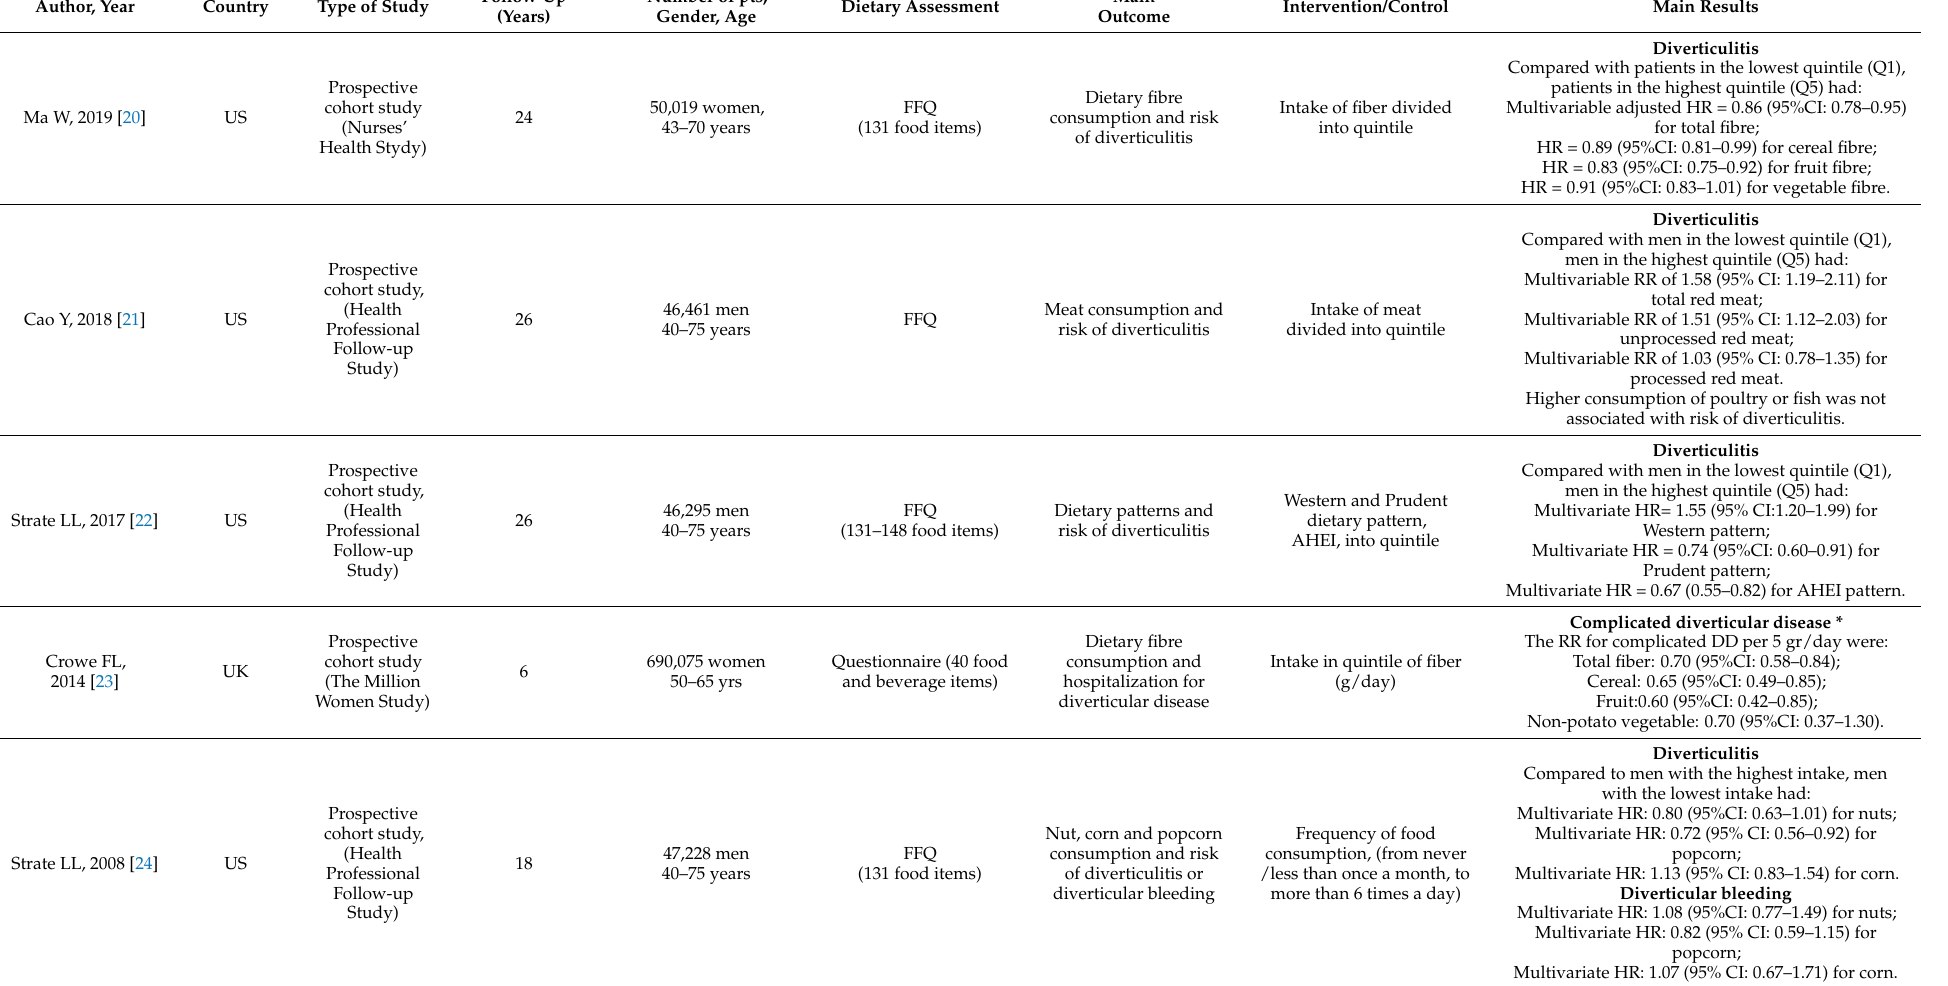
Table 1. Effect of fiber and meat consumption in the prevention of acute diverticulitis and diverticula